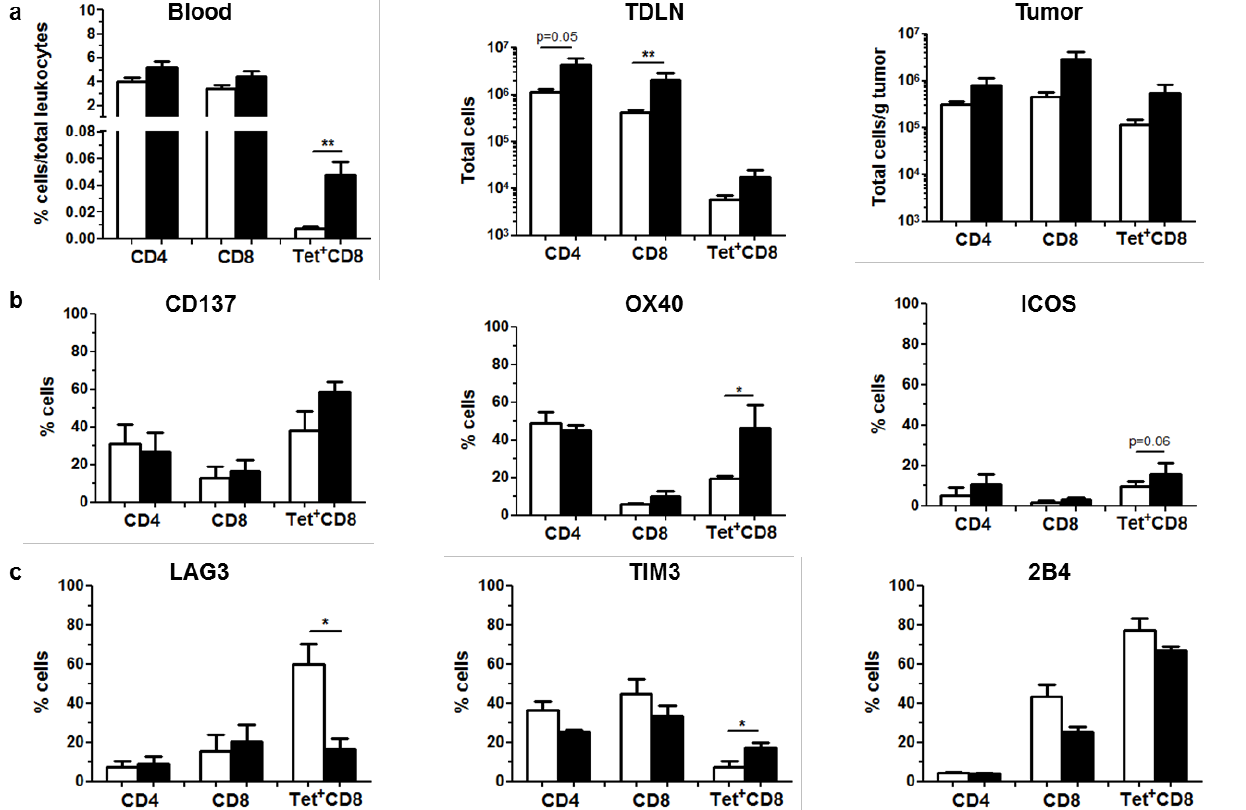
Figure 3. Local expression of aPD-L1 stimulates antitumor immune responses. C57BL/6 mice bearing subcutaneous MC38 tumors ( n = 5) were treated as described in Figure 2. Mice were sacrificed after the 5th day of aPD-L1 expression for collection of blood, TDLNs and tumors. Immune cell populations were analyzed by flow cytometry. Control and HCA-EFZP-aPD-L1-treated groups are represented as white and black columns, respectively. ( a ) Quantification of CD4 + , CD8 + and tumor-specific (Tet+) CD8 + T cells in peripheral blood (percentage of total leukocytes), TDLNs (total cells) and tumor extracts (total cells/g of tumor). ( b ) Percentage of cells expressing the stimulatory receptors CD137, OX40 and ICOS in the surface of these cell populations isolated from tumors. ( c ) Percentage of cells expressing the inhibitory receptors LAG3, TIM-3 and 2B4 in the same cells. * p < 0.05, ** p < 0.01, Mann–Whitney U test. Data are represented as average ± SEM.